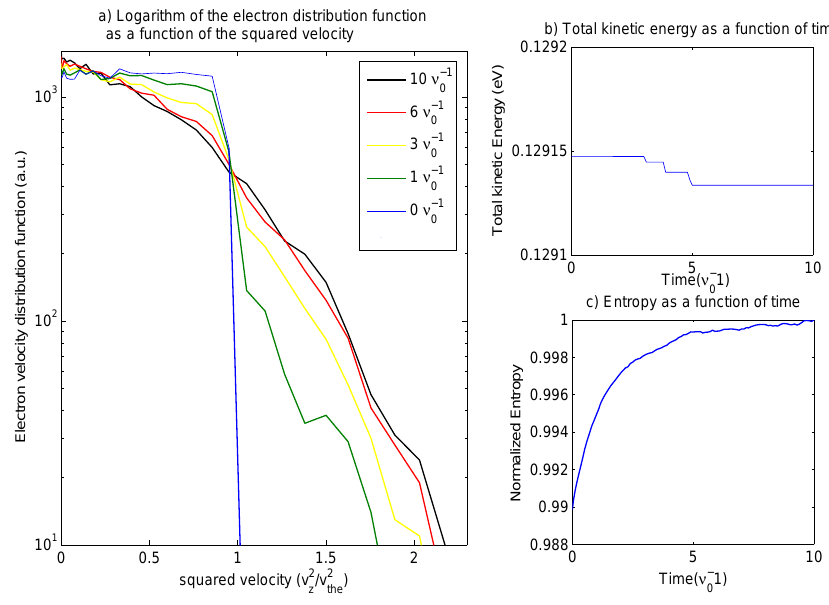
Fig. 3. Characteristics of the electrons for different times when only e/n collisions are considered: (a) The electron distribution function in logarithmic scale versus normalized squared velocity. The different colors represent different times during the simulation (b) The total kinetic energy as a function of normalized time (c) The entropy as a function of normalized time